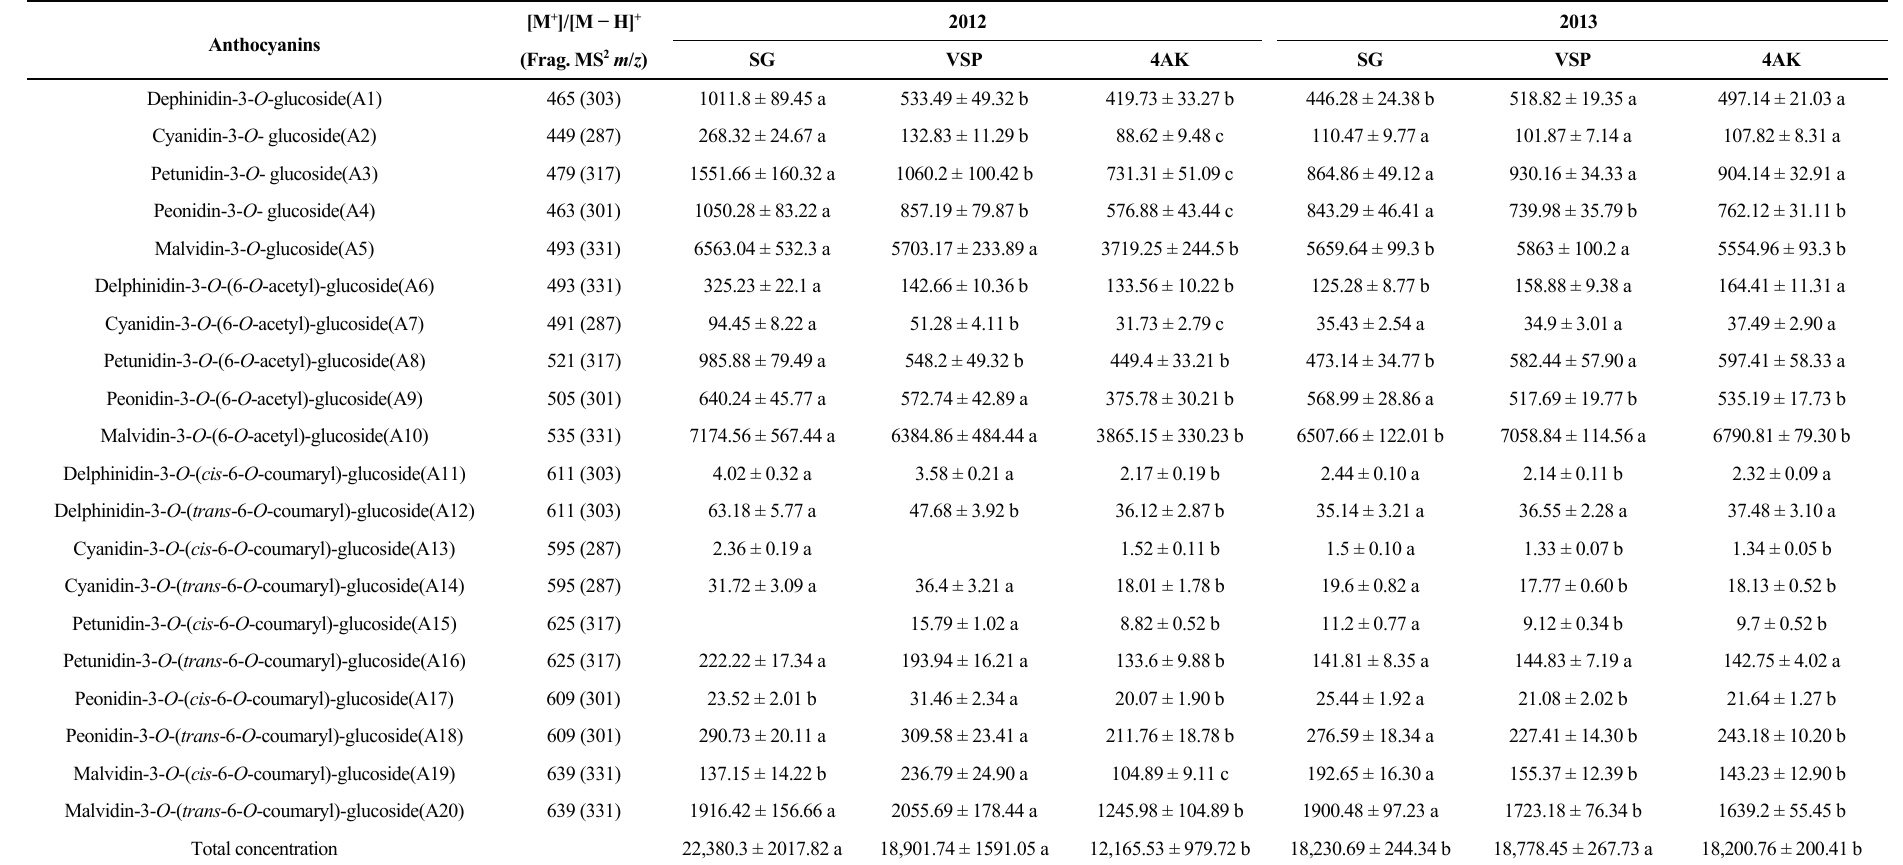
Data represent mean value ±SD for three replicates. Different letters within a row for the same year indicate significant differences between treatments calculated by Duncan’s test ( p < 0.05). [M + ], molecular ion; [M − H] + , fragment ion; DW, dry